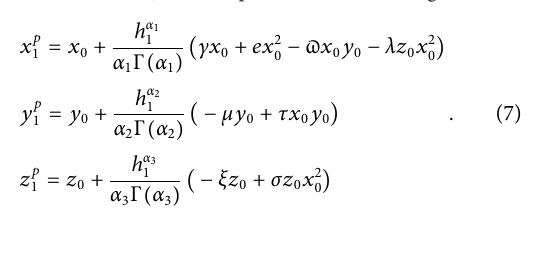
Figure 2. When α i ( i (cid:4) 1 , 2 , 3 ) (cid:4) 0 . 95, the chaotic attractors of